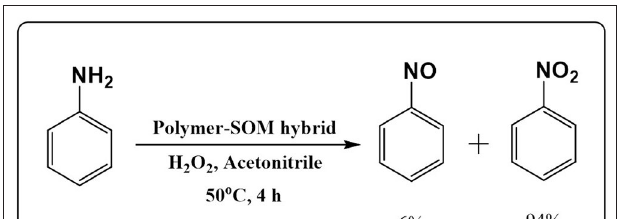
of tetrakis(4-aminophenyl)methane by [SiW 11 O 39 ] 8 − in the